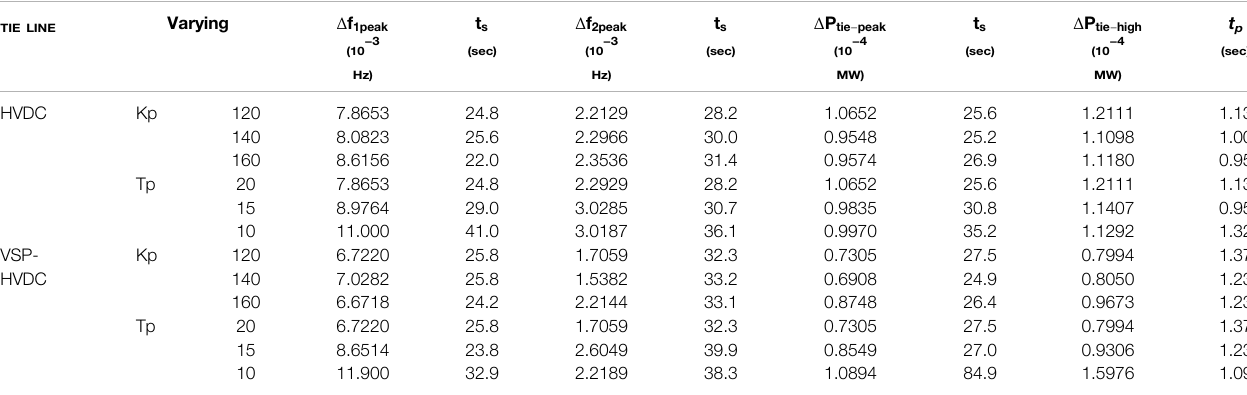
TABLE 3 | Sensitivity analysis of the presented two-area system. TIE